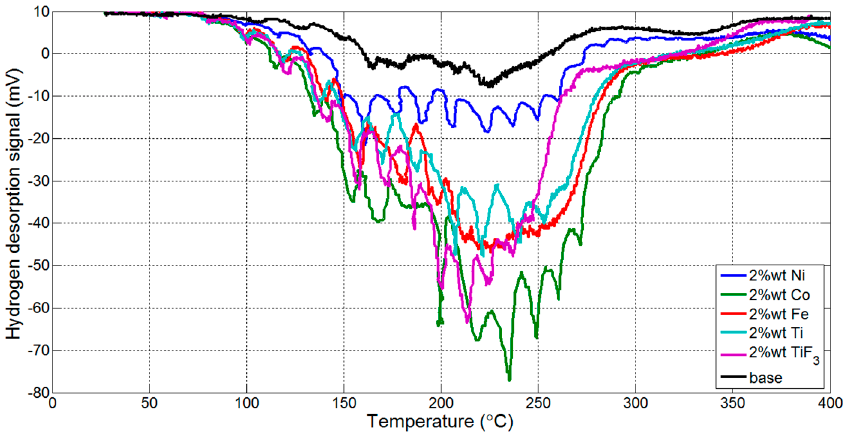
Figure 4. TPD characteristics of different catalysts on LiNH 2 -nanoMgH 2 (2:1) from TPD analysis.